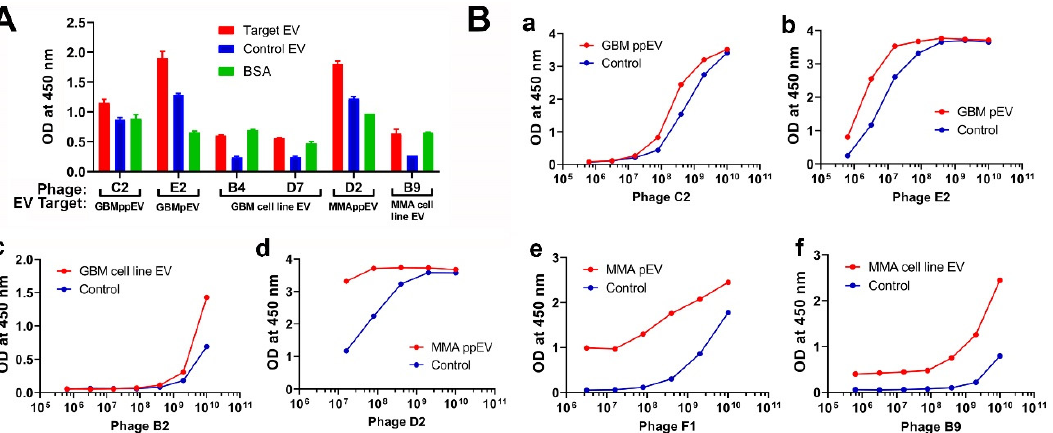
Figure 2. ELISA demonstrates that phage peptides selected by brain tumor extracellular vesicles are specific to panning EVs. ( A ) Direct ELISA shows that phage peptides are specific to panning brain tumor EVs. The target EVs include GBM and MMA ppEVs (from pooled plasma), pEVs (from individual plasma), and tumor cell line EVs. EVs coated on a high-binding ELISA plate (50 mg/mL) were incubated with corresponding phage (2 × 10 9 pfu/well). Bound phage peptides were detected by mouse anti-M13 pIII-HRP antibody (1:5000 dilution) followed by TMB substrate color detection. Each representative phage peptide (labeled in letters) was shown for OD values to corresponding panning EVs (target EV), control EVs, and BCA. ( B ) Dose–response ELISA demonstrating specific bindings of phage peptides to panning brain tumor EVs. GBM ( B - a – c ) and MMA EVs ( B - d – f ) (pooled plasma, individual plasma, and tumor cell line EVs) at 50 mg/mL were directly coated onto wells of ELISA plates, followed by incubation with corresponding phage peptides in serial 5-fold dilutions starting with 1 × 10 10 pfu/well. Detection was the same as described above. HC plasma EVs were used as controls for brain tumor plasma EVs ( a , b , d , e ), and normal human astrocyte EVs were used as controls for brain tumor EVs ( c , f